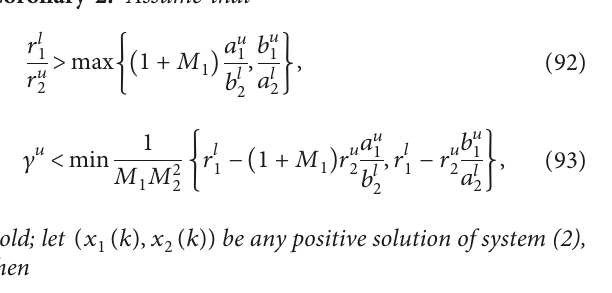
x k ,x k ,u k ,u k of system (88), with the initial 1 ( 2 ( 1 ( 2 ( ( ) ) ) ))